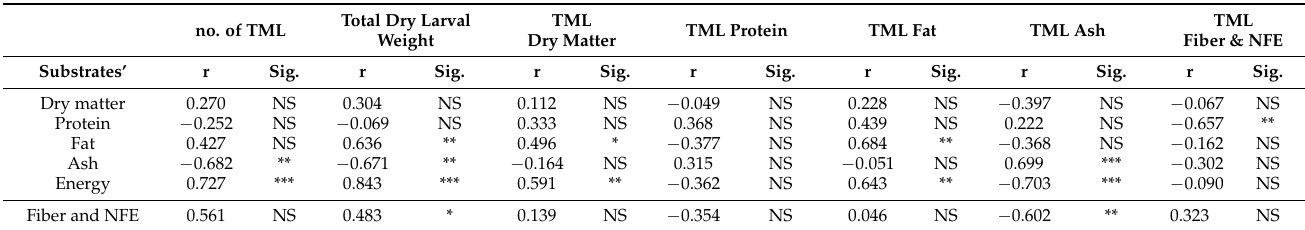
Table 4. Correlation analysis between the substrates’ proximate composition and the characteristics of Tenebrio molitor larvae.